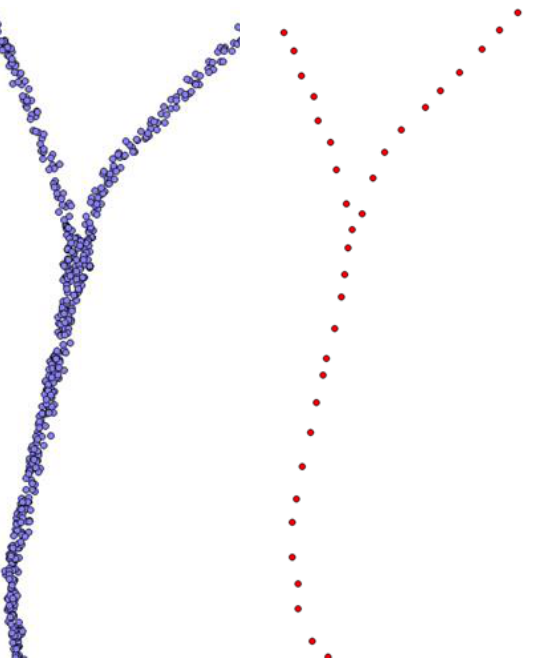
Figure 6. Comparison of original GPS points ( left ) and representative points ( right ).